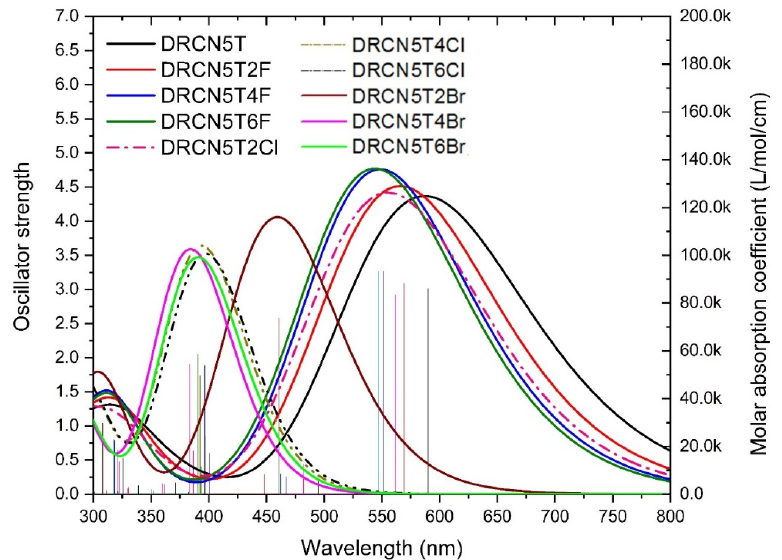
Figure 10. Calculated UV–Vis spectra of eight designed molecules obtained with CAM-B3LYP/6 − 31+ G(d) in PCM model.